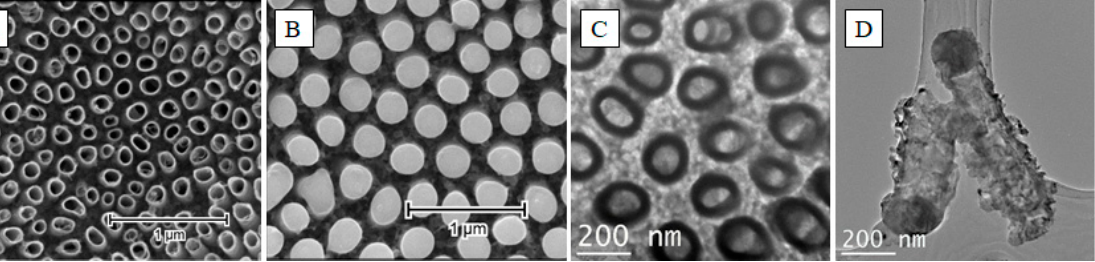
Figure 11. SEM images of as-anodized titania nanotubes ( A ), and nanotubes after the laser-treatment ( B ). TEM images of the hollow nanopillars from the top ( C ) and side ( D ). Reprinted with permission from [43].